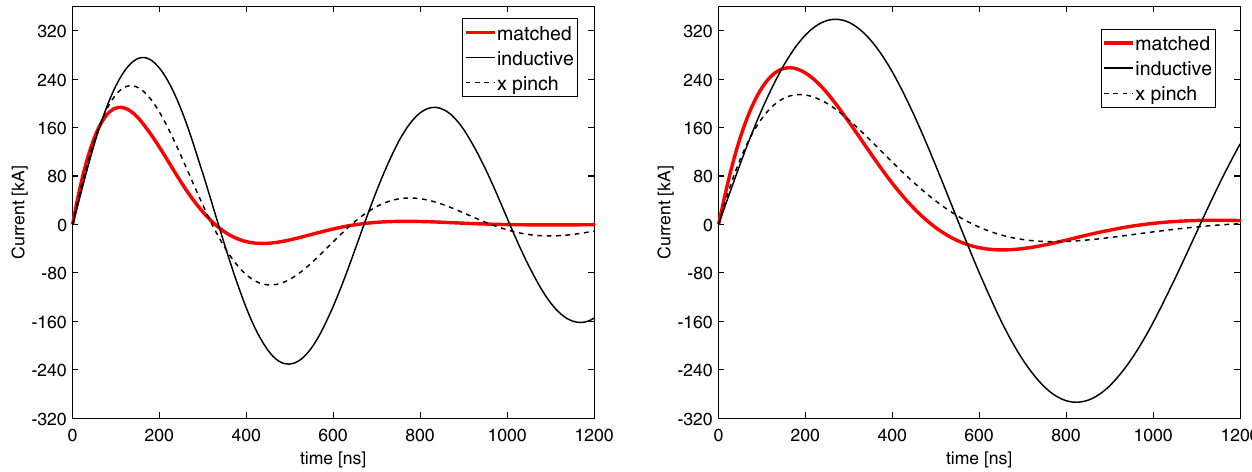
FIG. 7. Simulated output currents into matched, inductive, and x-pinch loads for a standard-brick pulser (left) and a dry-brick pulser (right). Both systems use four bricks and include a 6-nH